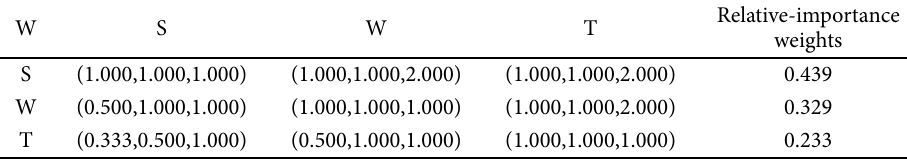
Table 4. The relative-importance weights for the “W” group